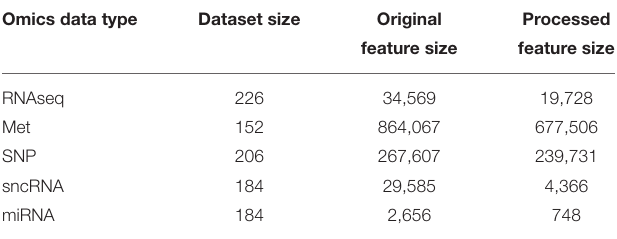
TABLE 3 | Dataset and feature sizes of multi-omics data before and after